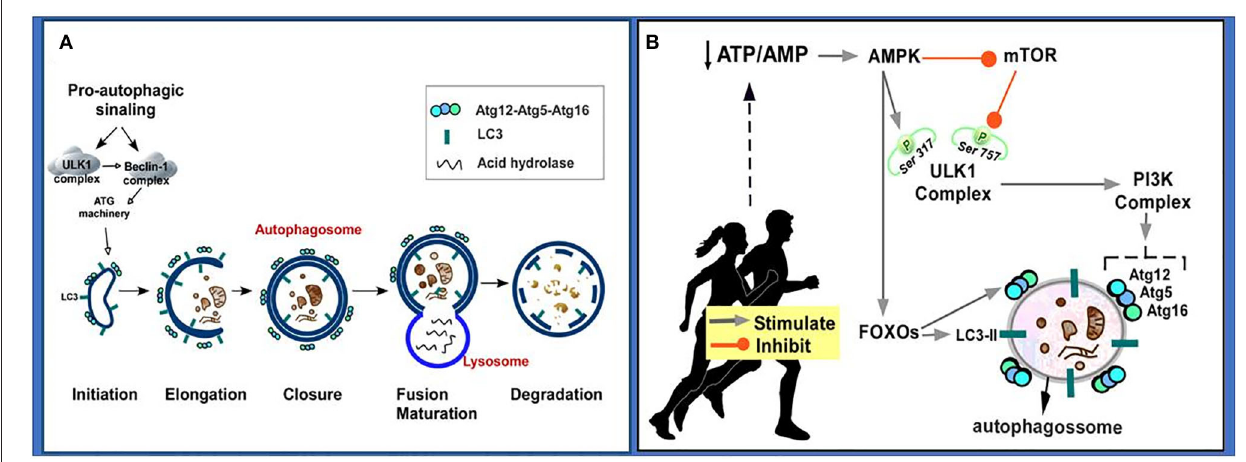
FIGURE 3 | Autophageal mechanism and stages. (A) Pro-autophagic signaling induces ULK1 activation and Beclin-1 complex, activating the ATG machinery, thereby initiating the autophagy stages consisting of initiation, elongation, closure and autophagosome formation, autophagosome fusion with lysosome and degradation. (B) Physical exercise causes a decrease in the ATP/AMP ratio by activating AMPK. AMPK inhibits the mTOR pathway, so ULK Ser 757 phosphorylation will be decreased and it may interact with AMPK and be activated by phosphorylation on Ser 317 . AMPK phosphorylated ULK1 becomes active and may initiate autophagy. PI3K activation occurs culminating in increased expression of autophagy-related proteins (Atg12, Atg5, Atg16). AMPK also promotes signaling of autophagy-related transcription factors (FOXOs), thereby increasing the expression of autophagy-related proteins (Atg12, Atg5, Atg16, LC3-II). Atg, autophagy-related protein; ATP/AMP, adenosine triphosphate/adenosine monophosphate; AMPK, AMP-activated protein kinase; Beclin-1, autophagy-related protein; FOXO, Forkhead box O; LC3II, microtubule-associated protein 1 light chain 3–form II; mTOR, mammalian target of rapamycin; PI3K, Phosphatidylinositol 3-kinase; UKL1, Unc-51-like kinase